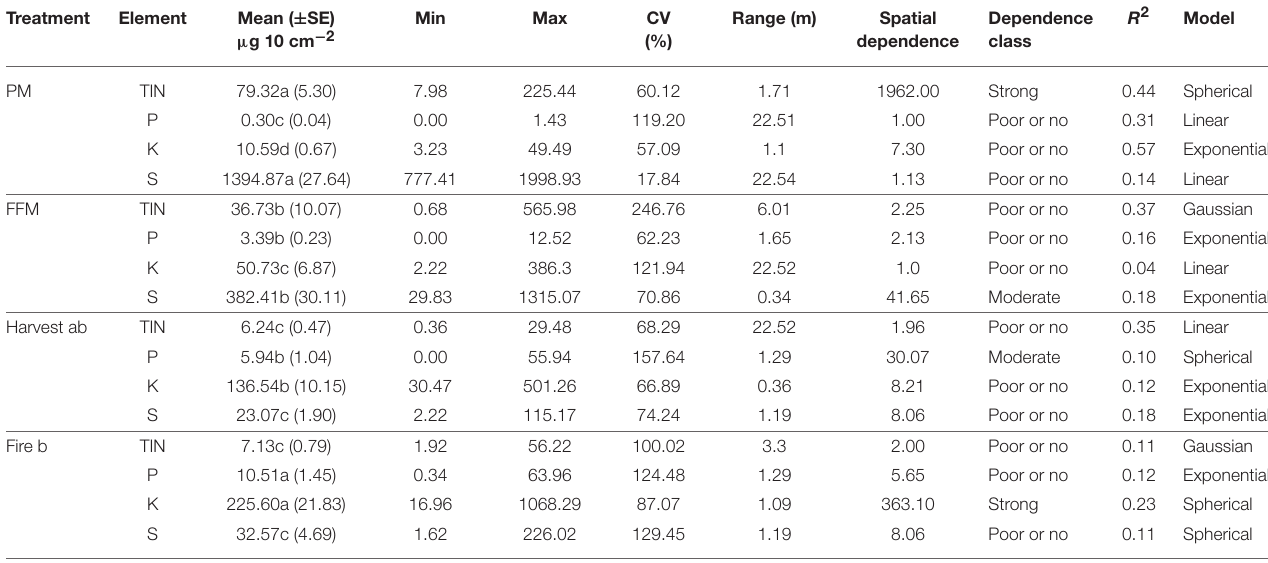
TABLE 2 | Selected macro nutrient characteristics for sites including peat mineral-mix (PM), forest floor mineral-mix (FFM), Harvest (ab) by timber harvesting disturbed a/b ecosite, Fire (b) a by forest fire disturbed type b ecosite. Treatment Element